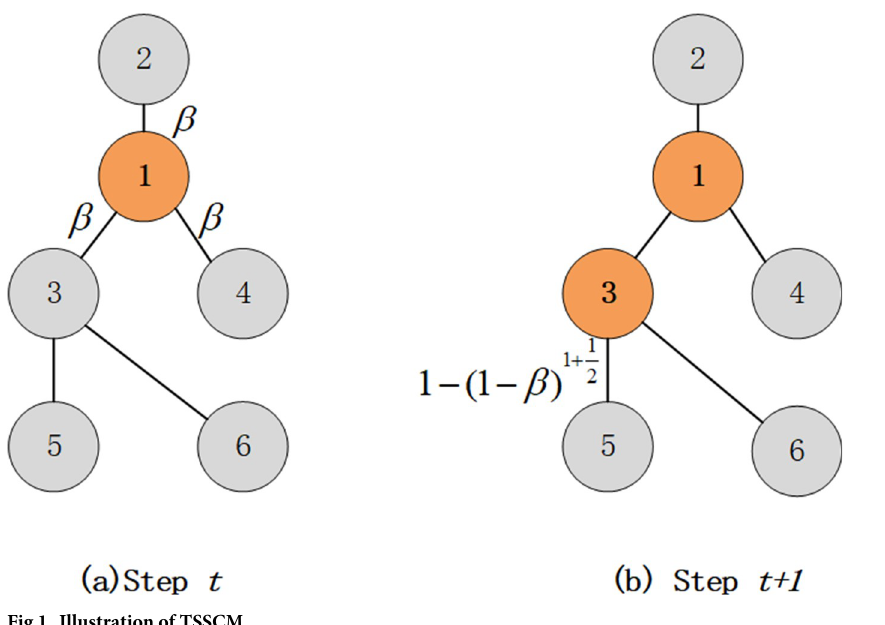
Fig 1. Illustration of